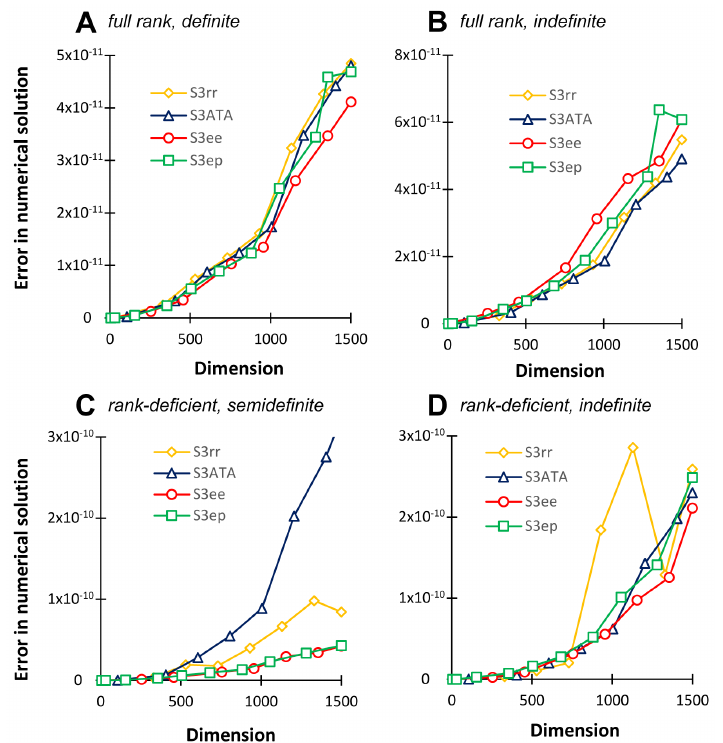
Figure 1. Comparative analysis of the four variants of the orthogonally scaled complex ABS algorithm on randomly generated dense complex systems of linear equations.